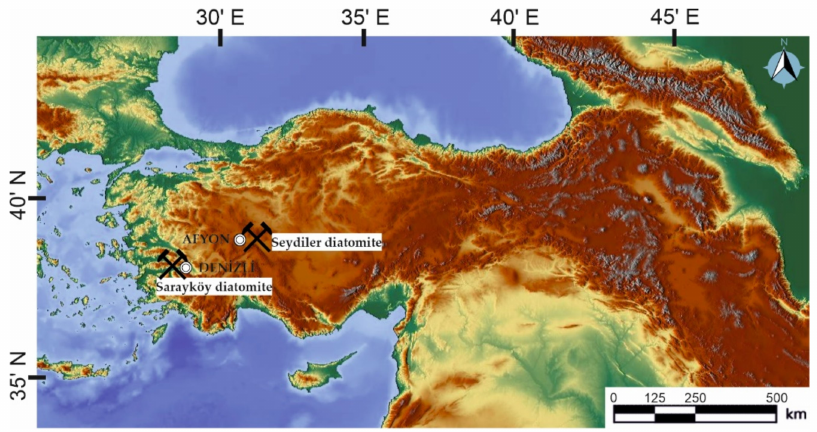
Figure 1. Locations of diatomite samples from the Aegean Region of Turkey (Afyon and Denizli).